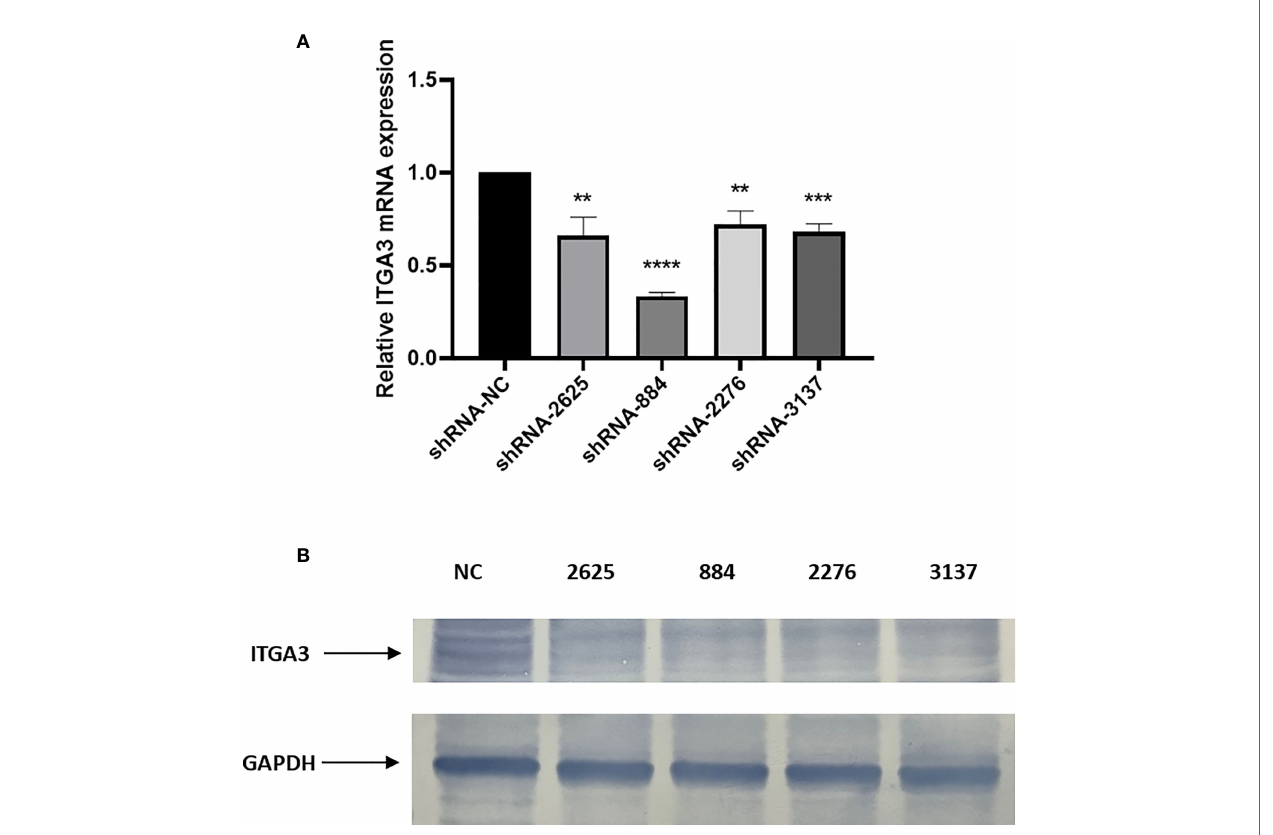
FIGURE 9 | Knockdown of ITGA3 inhibits proliferation of PTC cells in vitro . (A) shRNA transfection ef fi ciency analysis with RT-PCR. (B) Western blot test of the expression of ITGA3 protein after transfection (****P < 0.0001, ***P < 0.001, **P < 0.01, compared with negative control).